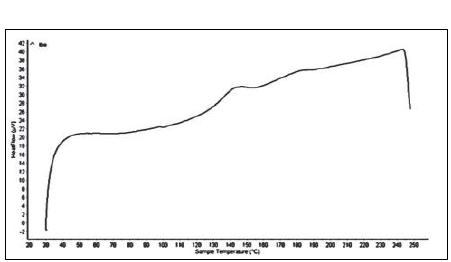
Figure 10. DSC thermogram of selected